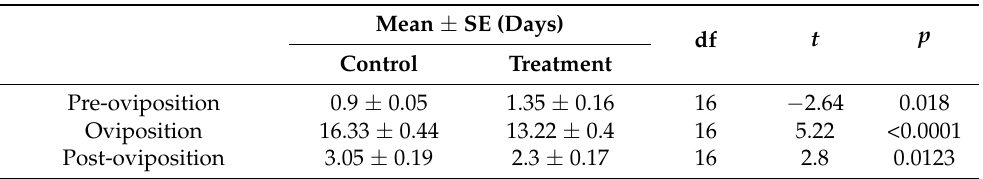
Table 5. Effects of sublethal concentration of farnesyl acetate on pre-oviposition, oviposition, and post-oviposition periods (day ± SE) of P. xylostella.